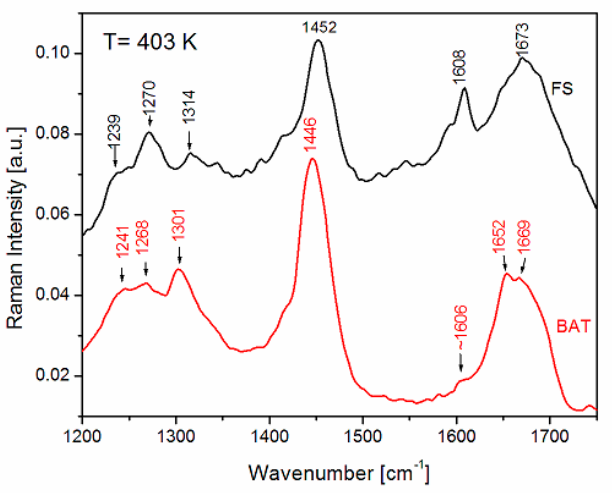
Figure 6. Comparison of Raman spectra of FS and BAT collagen in the range of amide I and amide III vibrations measured at 403 K.